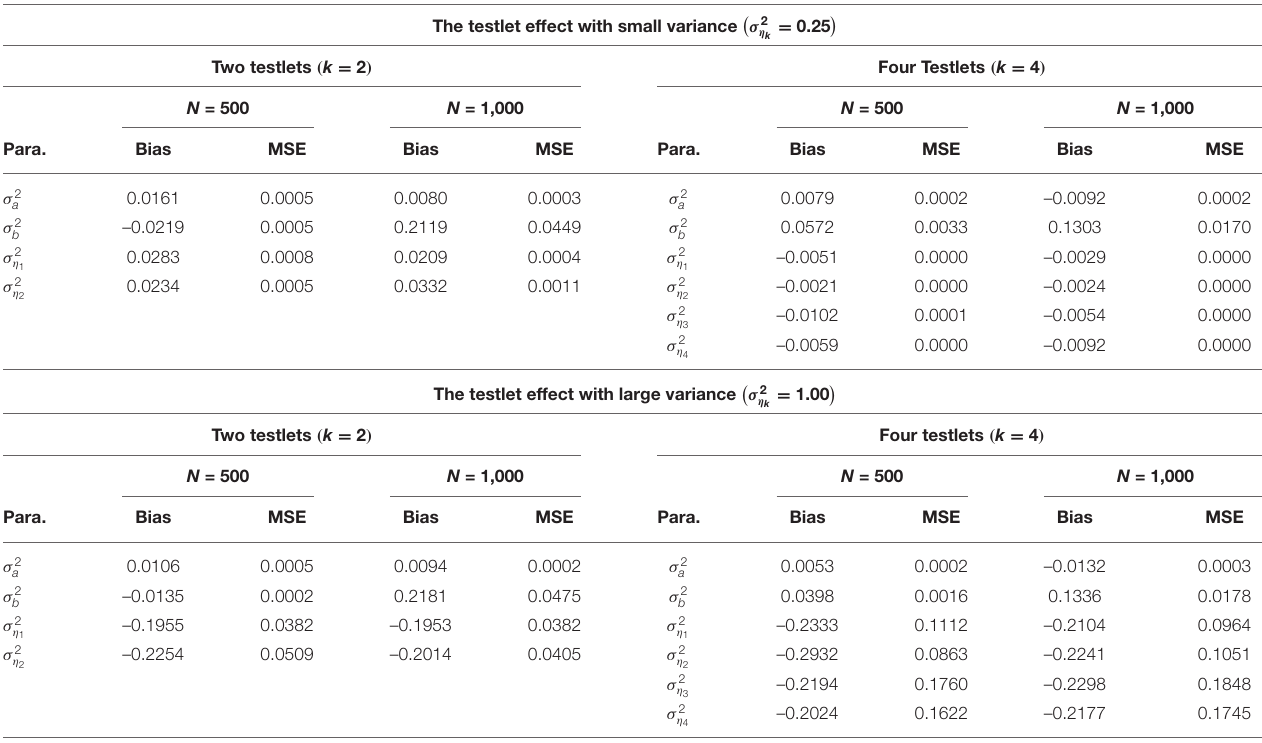
TABLE 4 | Evaluating accuracy of the variance parameter estimates.